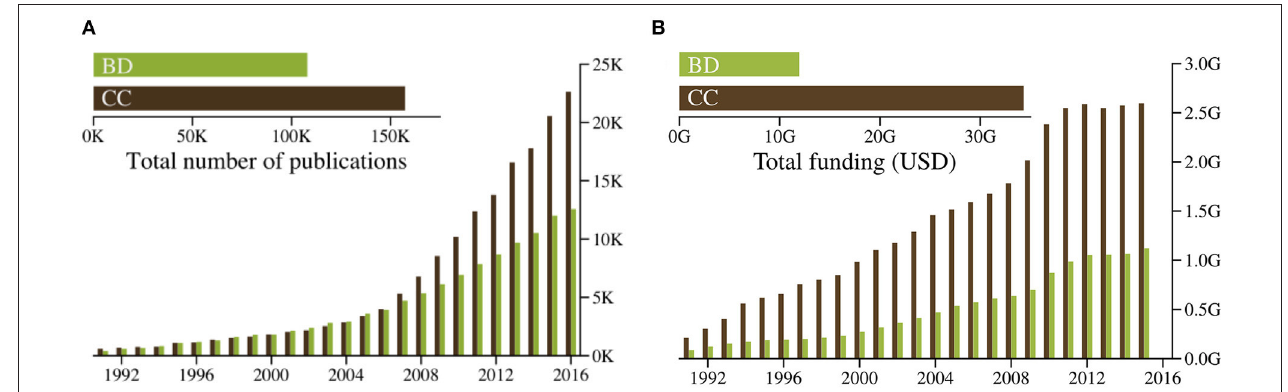
FIGURE 1 | (A) Worldwide scientific papers published in peer-reviewed literature on biodiversity (green) or climate change (brown) topics. (B) Public research funding in US and Canada dedicated to biodiversity (green) or climate change (brown) issues.